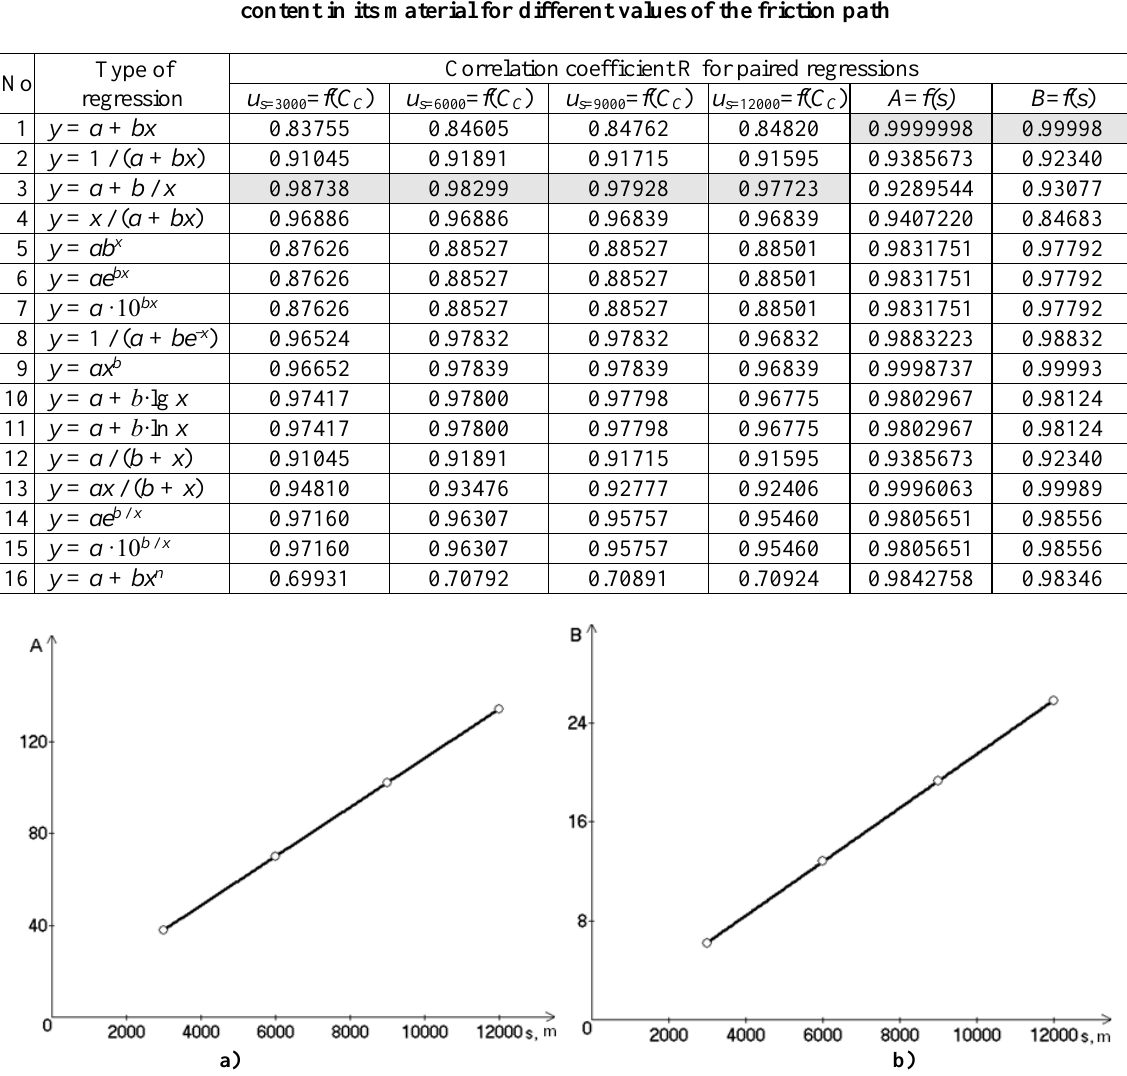
Fig. 2. Dependences of regression coefficients on the path of friction (a) - A = f (s), (b) - B = f (s): actual ○, theoretical